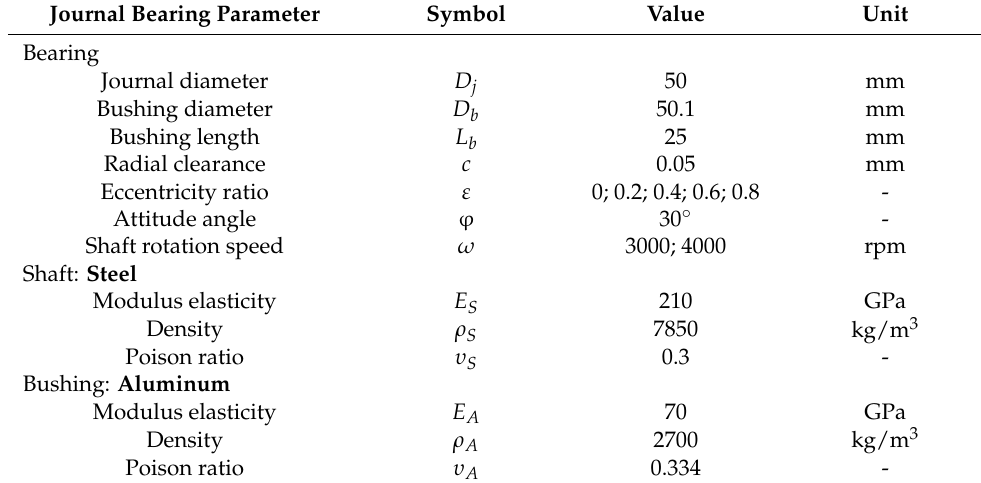
Table 1. Parameters of the model.